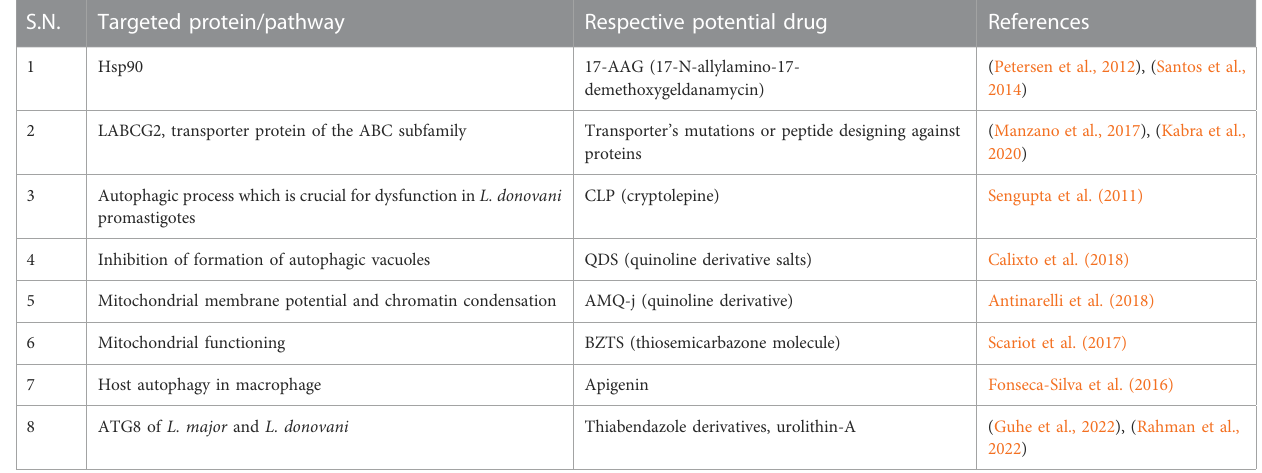
TABLE 2 Drugs showing anti-leishmanial effect by modulating the autophagy process and their respective targets.